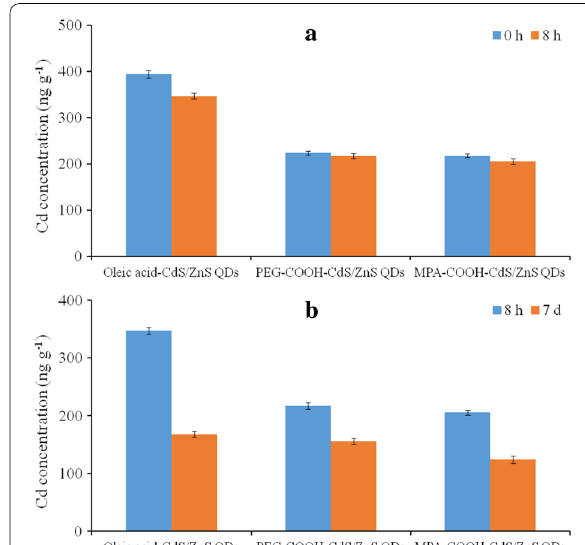
Fig. 3 The content of Cd in mangrove ( Kandelia obovata (S., L.) Yong) root after exposures of Oleic acid-CdS/ZnS QDs, PEG-COOH-CdS/ZnS QDs and MPA-COOH-CdS/ZnS QDs at the a rapid depuration stages (0–8 h) and b slow depuration stages (8 h–7